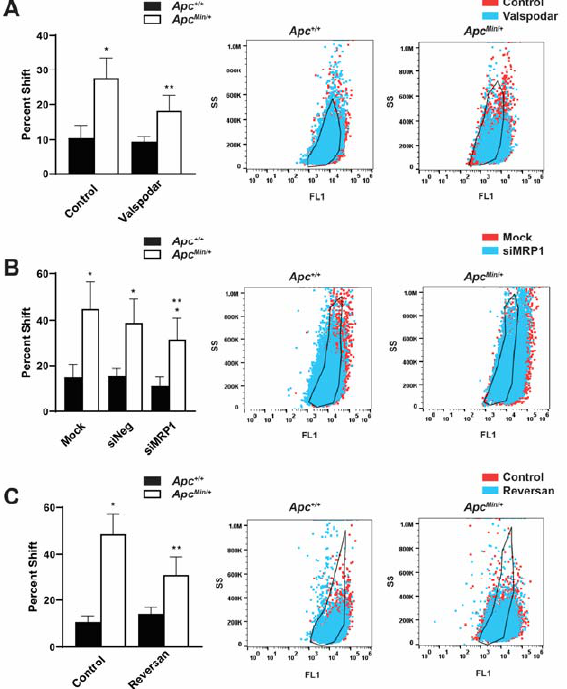
Figure 4. Inhibition MDR1 and MRP1 enhances the ALDH High TIC population. ( A ) The ALDH High cell population in MMTV-PyMT; Apc Min/+ cells decreased following the inhibition of MDR1.